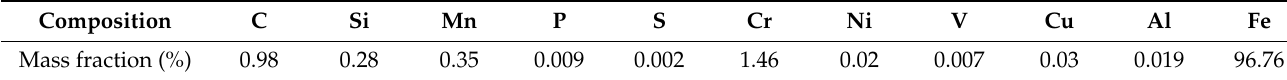
Table 1. Chemical composition of the steel bearing GCR15.